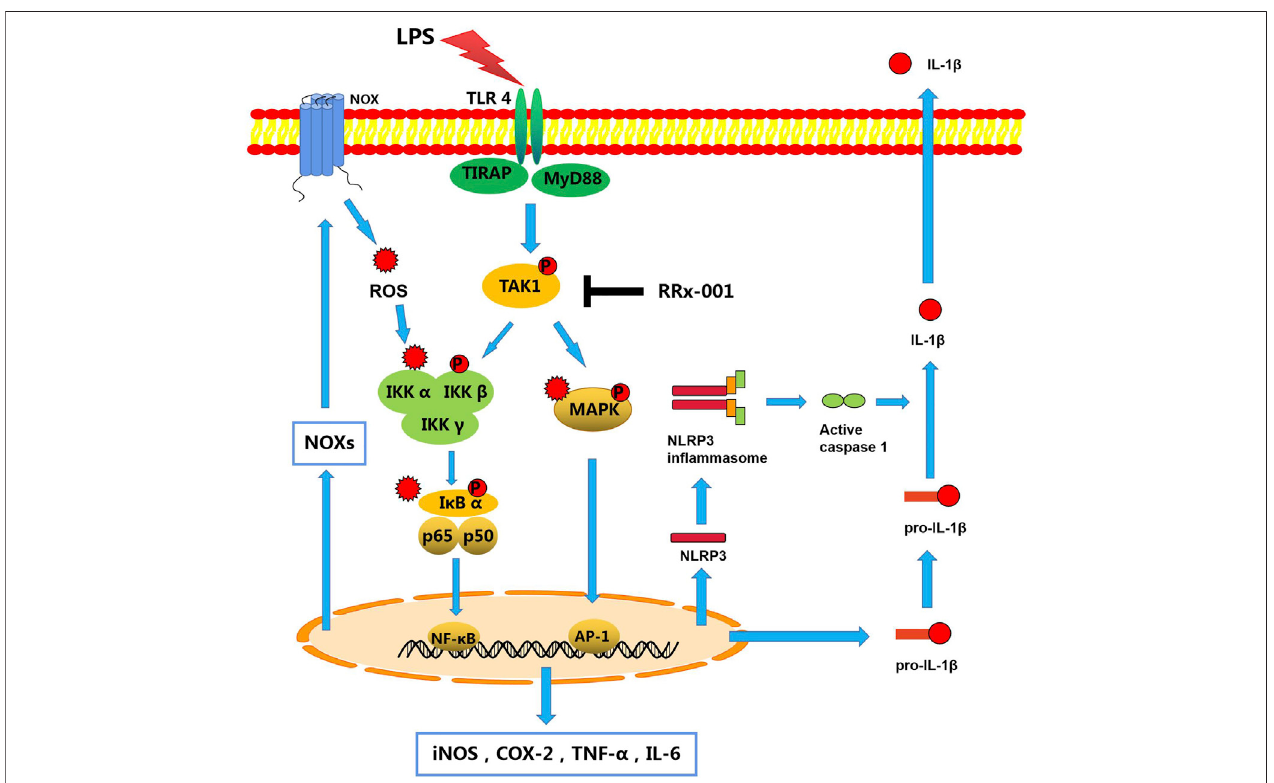
FIGURE 11 | A schematic diagram of RRx-001 mediated improvement of neuroin fl ammation. In LPS-stimulated microglia, activated TLR4 recruits MyD88 and TIRAP to phosphorylate TAK1, which subsequently promotes the synthesis and release of pro-in fl ammatory cytokines by activating NF- κ B and MAPK signaling pathways.Moreover,thetranscriptionalexpressionoftheNLRP3in fl ammasomeisalsoincreasedtoactivatecaspase-1,whichleadstothematurationandreleaseofIL- 1 β . In addition, the transcription and expression of Nox isoforms are mediated by transcription factors NF- κ B and AP-1 to induce oxidative stress, which exacerbates in fl ammation through activation of these two pathways. However, RRx-001 pretreatment inhibits the activation of TAK1, resulting in the inhibition of pro- in fl ammatory cytokines expression, NLRP3 in fl ammasome activation, and Nox-mediated oxidative stress through the NF- κ B and MAPK signaling